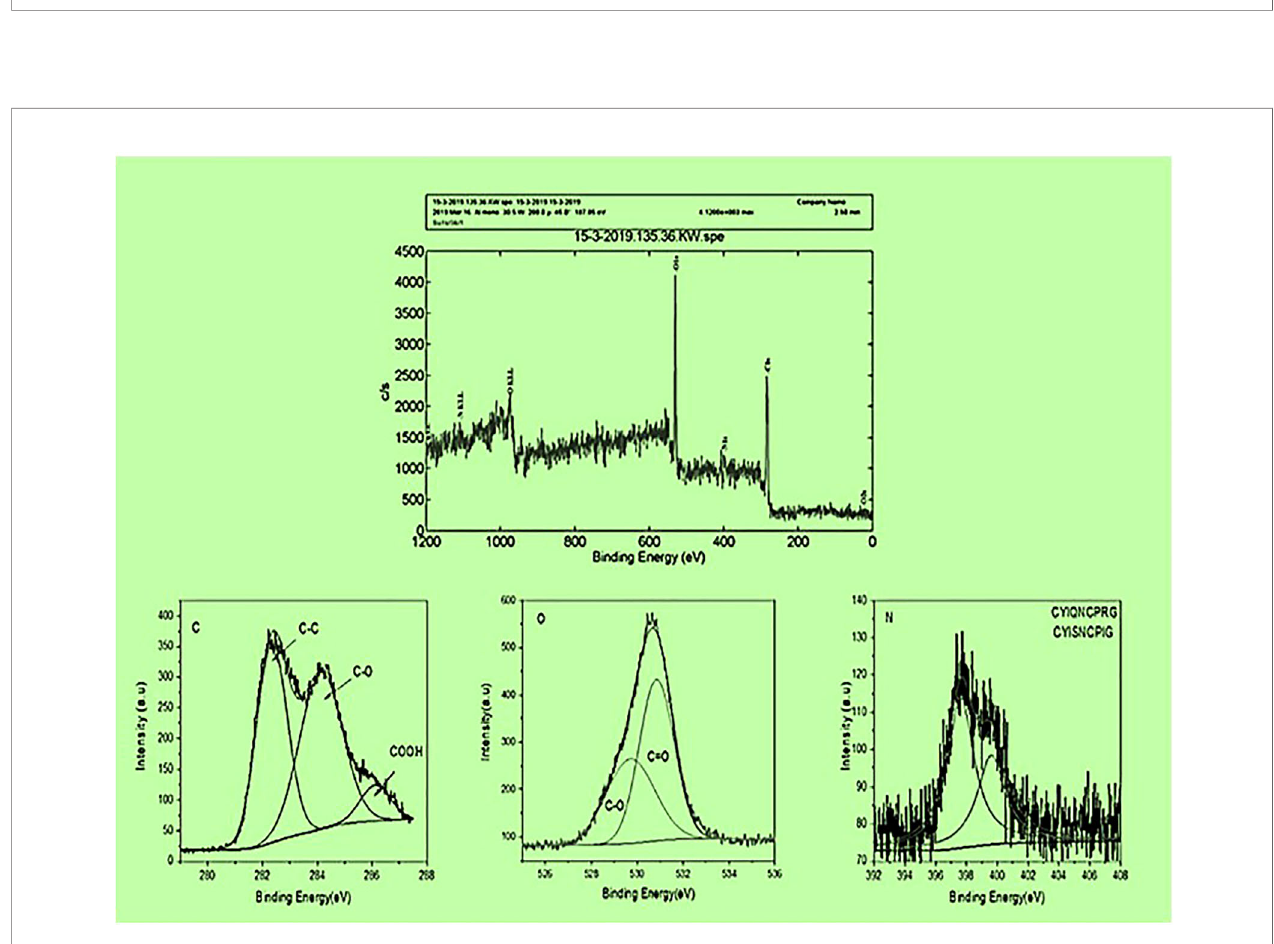
FIGURE 4 | XPS results of COOH-SWCNTCSPePs (single-walled carbon nanotubes with chitosan and